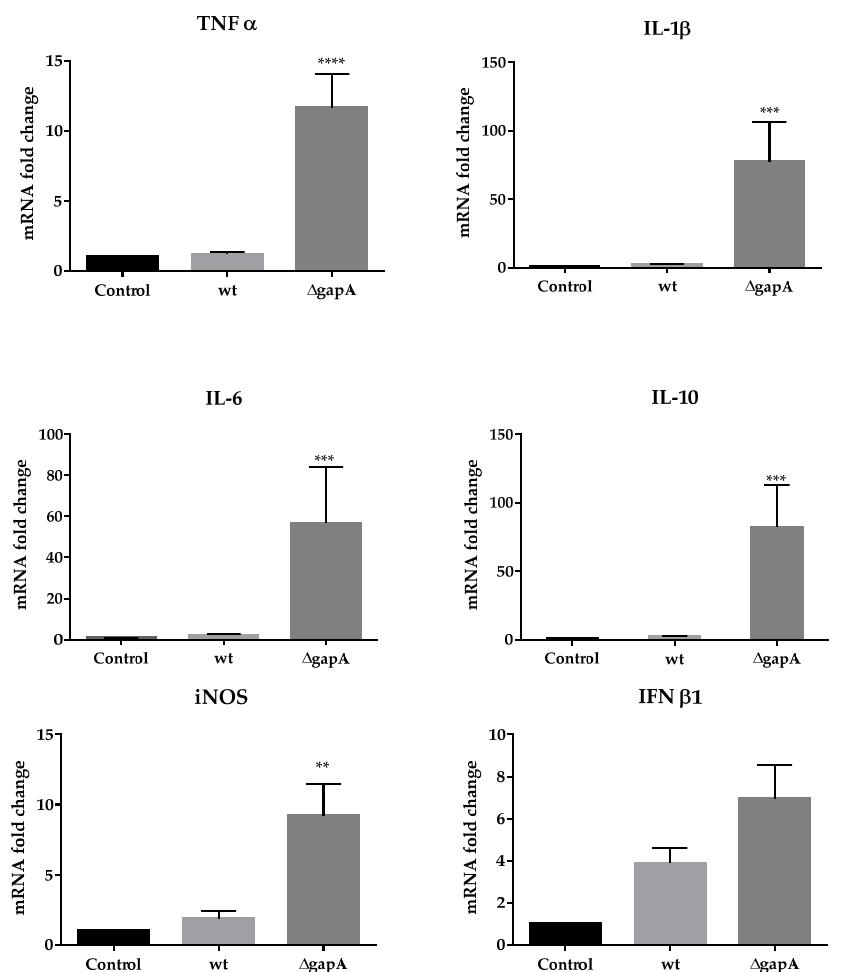
Figure 7. Real-time qRT-PCR quantification of selected cytokines in BMDMs infected with wt or ∆ gapA strains for 8 h. Results were compared to uninfected cells (control). Data are presented as a fold change in expression relative to control cells (set at 1). Data are shown as mean ± SEM. ** p <